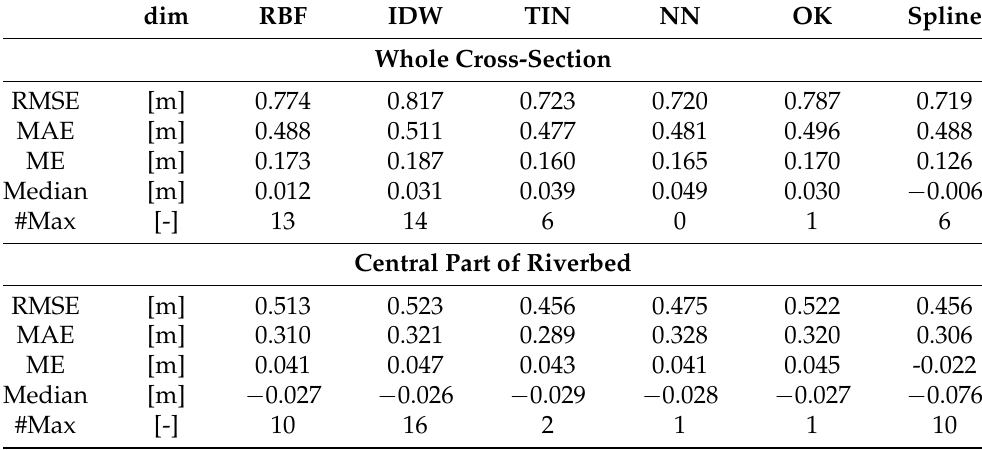
Table 1. Summary of the statistical parameters for the six interpolation